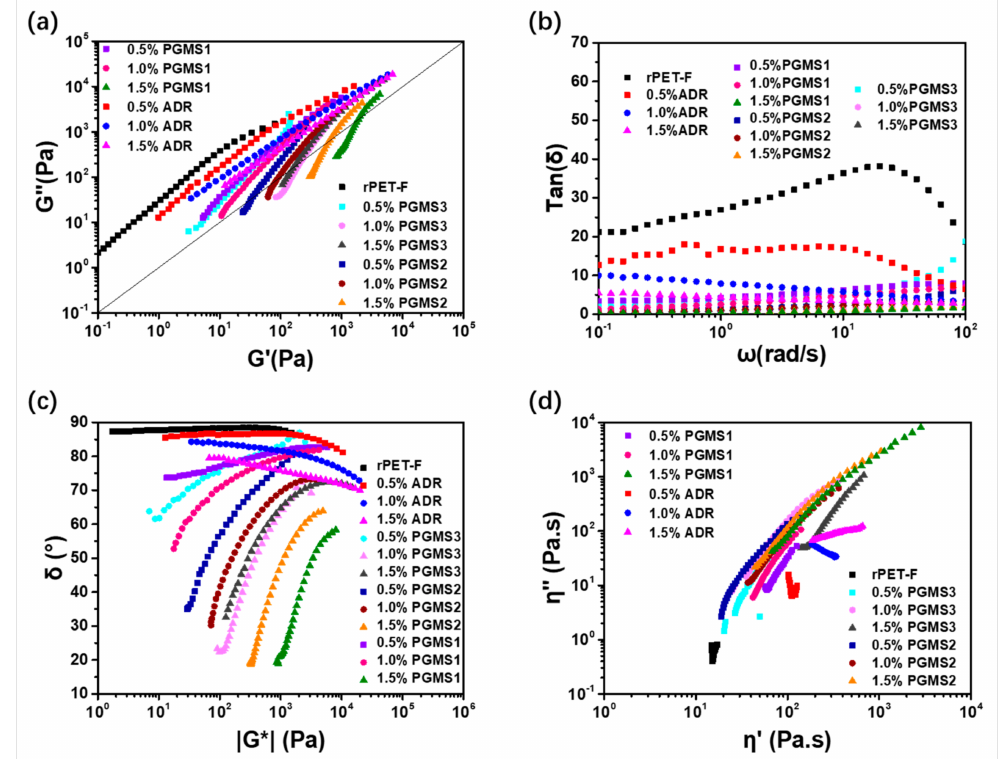
Figure 6. Han plots for various modified PETs ( a ), dynamic loss tangent (tan δ ) as a function of ω for various modified PETs ( b ), vGP plots for various modified PETs ( c ) and Cole–Cole plots for various modified PETs ( d